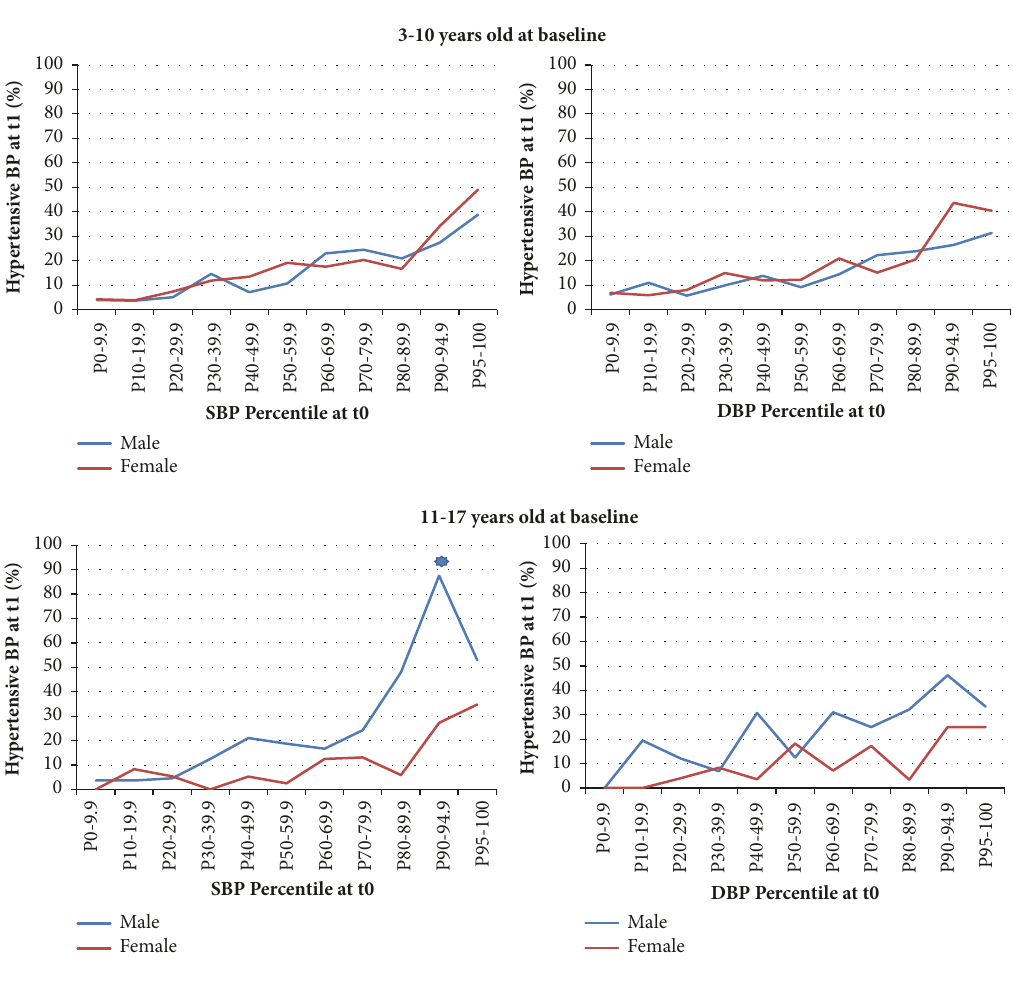
ranking to a greater extent due to chance. In other words, for combinations of risk factors, tracking coefficients are not an appropriate measure for assessing the predictability of future BP